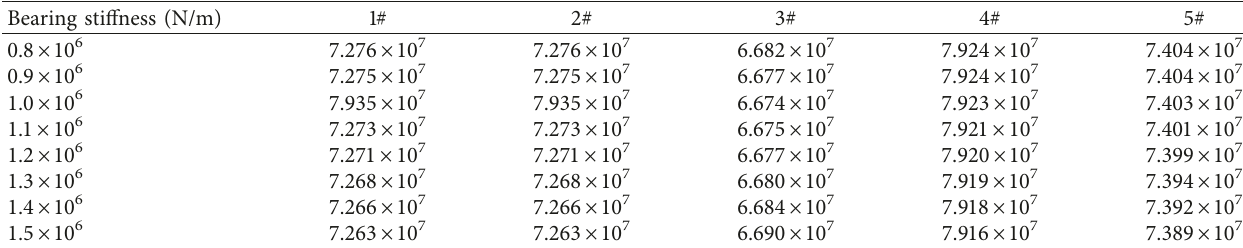
Table 6: Moment of pier bottom (N